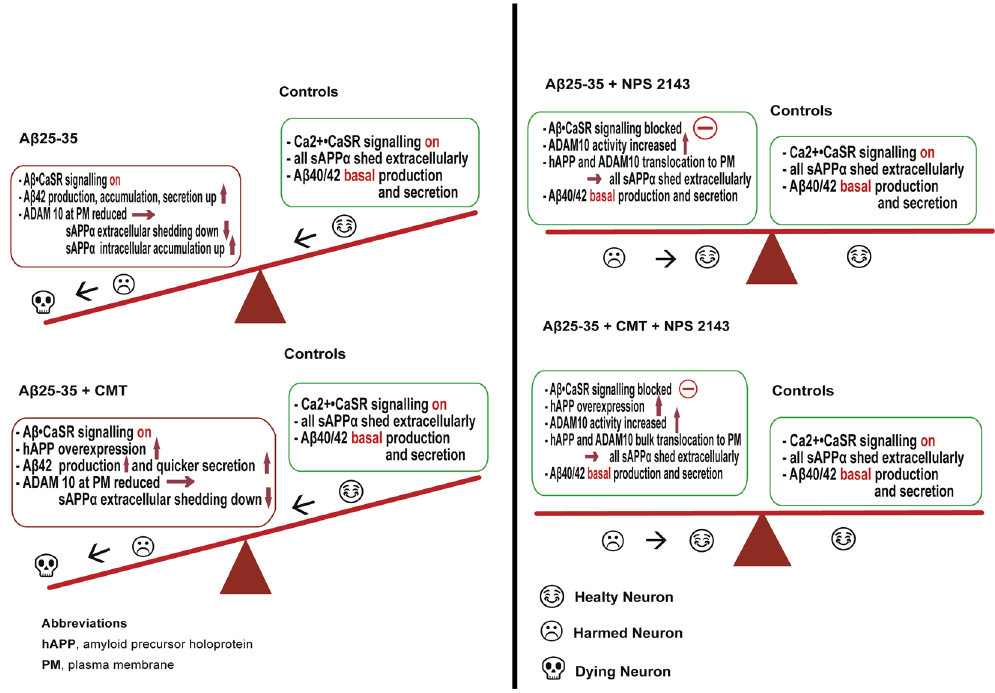
Figure 6. Mechanisms synopsis. Cartoon illustrating the concept that CaSR-dependent signalling can deeply affect the balance between hAPP NAP and AP and hence play a role in the promotion or prevention of AD development. Left panel . The main mechanisms by which A β 25–35 alone ( top ) or + CMT ( bottom ) alters the hAPP physiological NAP in favour of AP. Right panel . The main mechanisms by which calcilytic NPS 2143 restores the hAPP NAP while hindering the AP in A β 25–35 -exposed adult human astrocytes either in absence ( top ) or in the presence of CMT ( bottom ). The emojis indicate what most likely happens to the neurons exposed to the various agents (human astrocytes survive). See the text for further